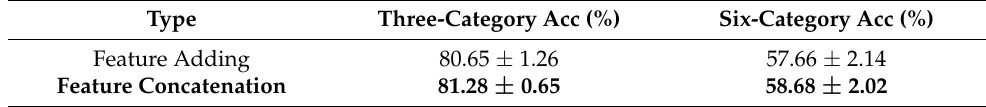
Table 9. Results of Feature Concatenation or Feature Adding in PCCAF.